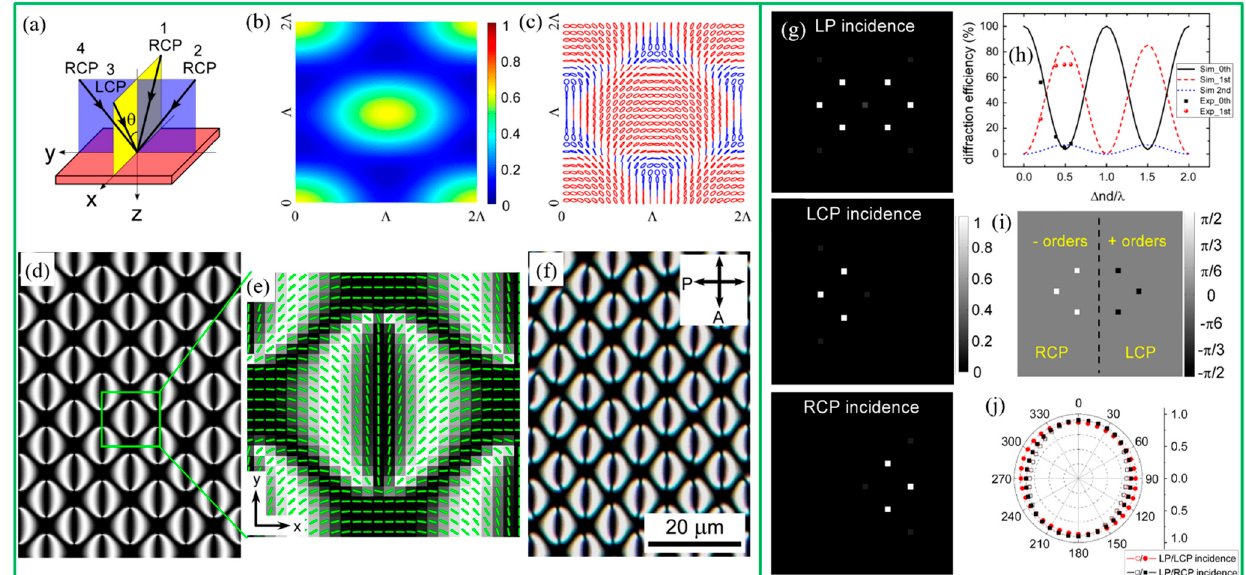
Figure 10. ( a ) Arrangement of the four interference beams. ( b ) Simulated intensity and ( c ) polarization states of the interference field. ( d , e ) Simulated LC texture and LC orientation between the crossed polarizers. ( f ) POM observation of the LC texture of the fabricated 2D PG. ( g ) The diffraction pattern varies with the input polarizations. ( h ) The diffraction efficiency as a function of relative phase retardation (Lines: Simulation result; Dots: Experiment result.). ( i ) Polarization state of the diffraction pattern. ( j ) Polar plot of the polarization measurement of the 1st-order diffractions. Reproduced with permission from Reference [49] © The Optical Society.